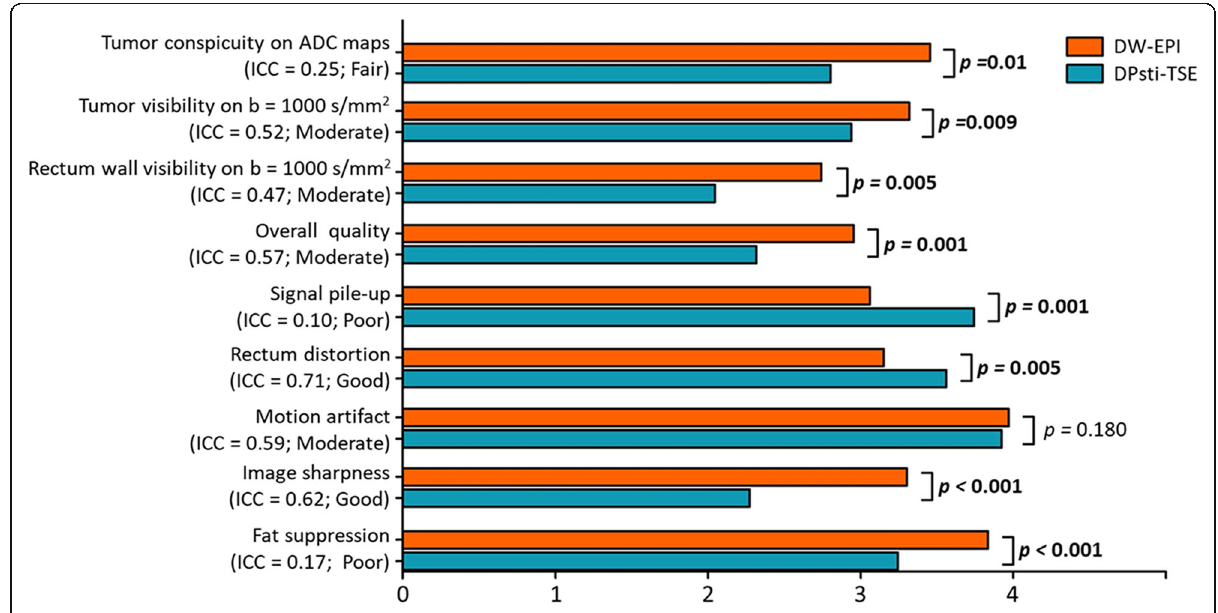
Fig. 2 The mean scores for DW-EPI and DPsti-TSE images, averaged over all patients and observers. For each parameter, the ICC value between two observers is shown in parentheses. ( DPsti-TSE diffusion-prepared stimulated echo turbo spin-echo, DW-EPI diffusion-weighted echo-planar imaging, ICC intraclass correlation